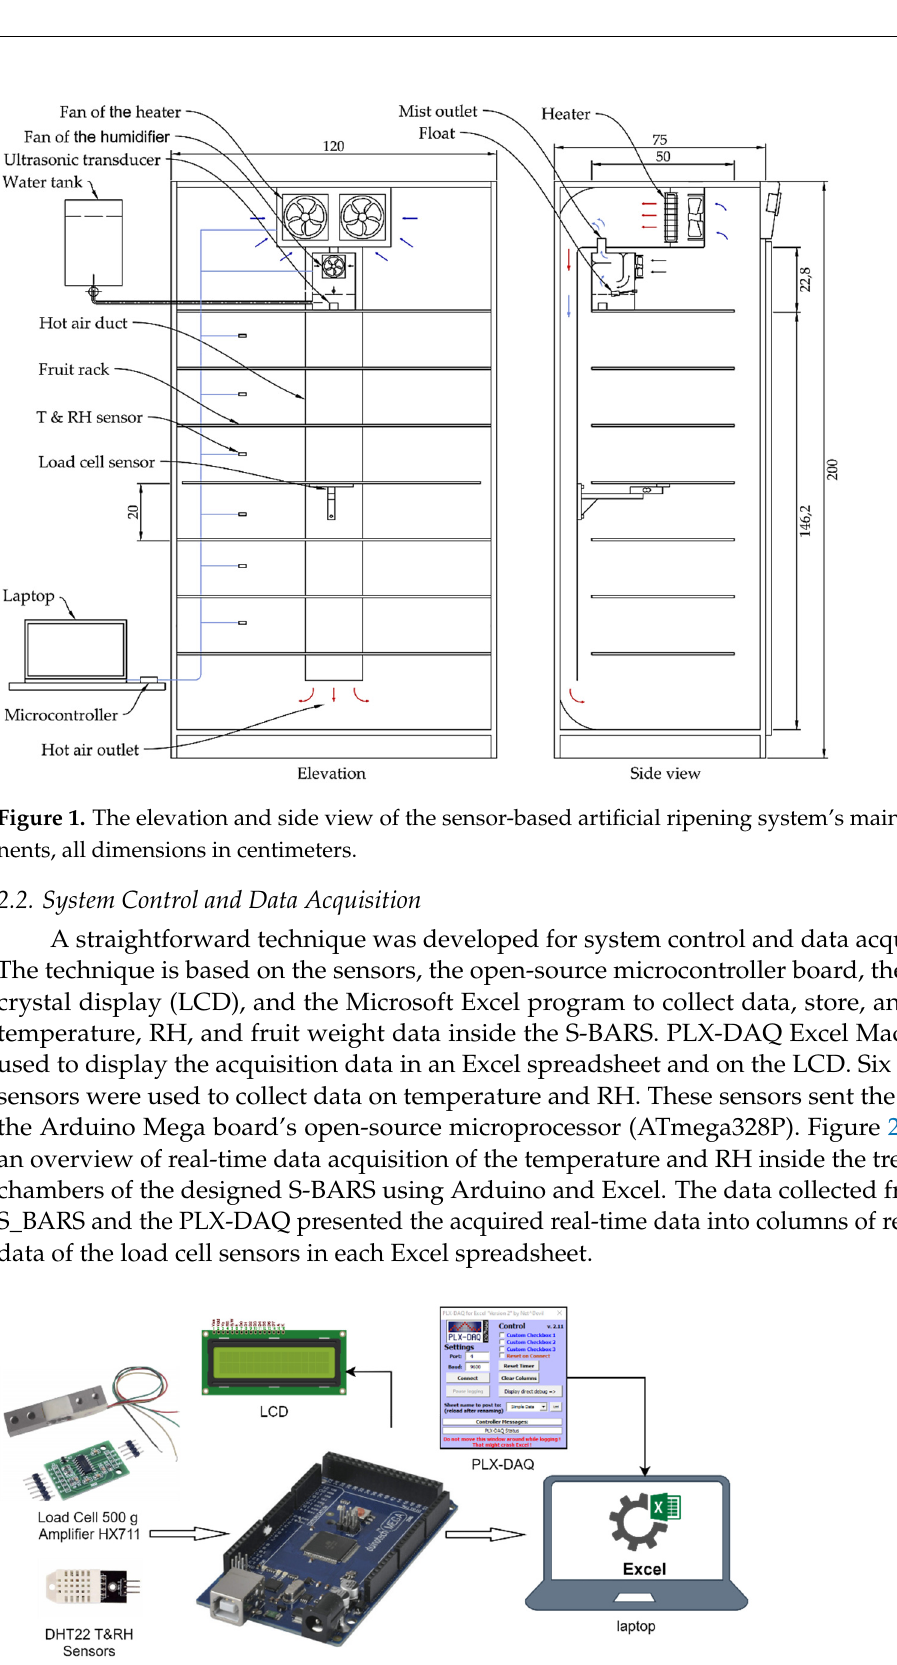
Figure 2. An overview of the real-time data acquisition method of temperature and RH inside the treatment chambers of the developed systems and weight loss during treatment using the sensors (DHT22 and Load Cell with amplifier HX711), Arduino Uno (ATmega328P), and Excel (PLX-DAQ Excel Macro).